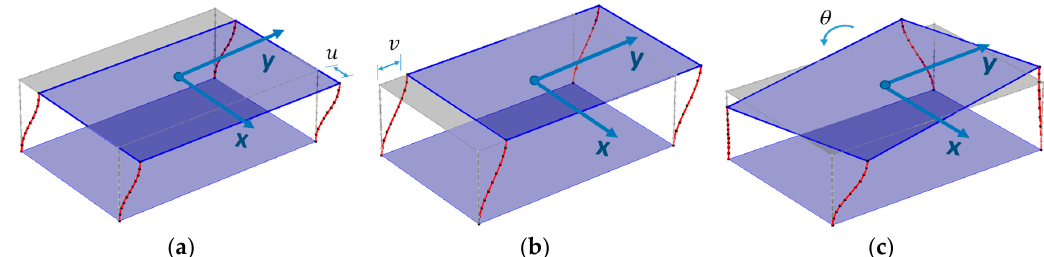
Figure 2. The three degrees of freedom of inter-story responses. ( a ) Inter-story displacement 𝑢 . ( b ) Inter-story displacement 𝑣 . ( c ) Inter-story torsion 𝜃 .